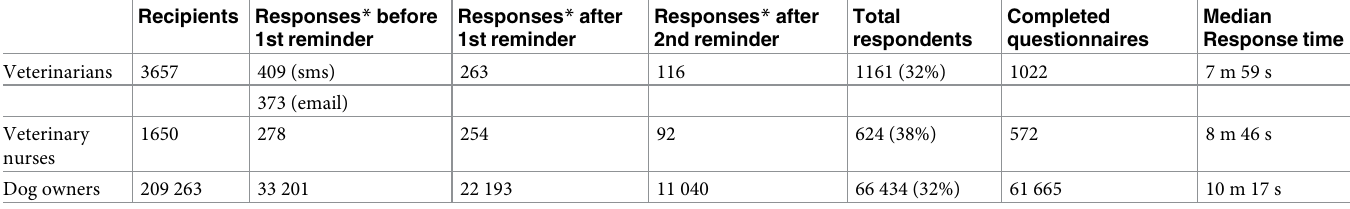
Table 1. Details of questionnaire recipients, responses before and after reminders, as well as median response time. Recipients Responses * before 1st